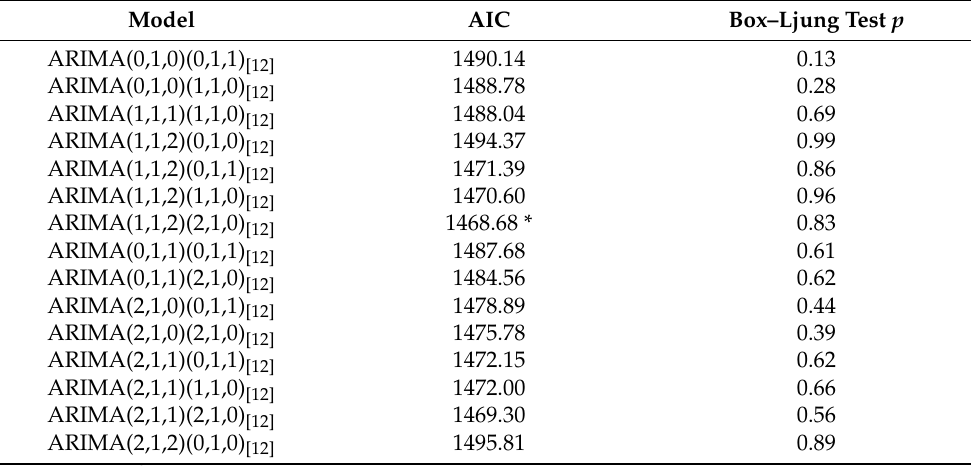
Table 3. All ARIMA models that passed the parametric test and their